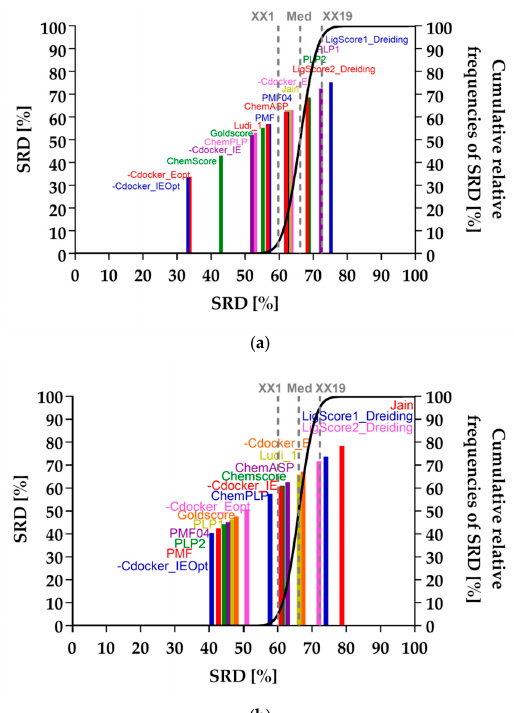
Figure 7. The sum of ranking differences (SRD) analysis of the 16 fitness functions calculated for each docking run: ( a ) CDOCKER; ( b ) GOLD. Normalized SRD values are plotted on the x and left y axes. The cumulative relative frequencies of SRD values for random ranking are plotted on the right y axis and shown as the black curve. Table 11. SRD ranking of the 16 fitness functions used in the CDOCKER run.